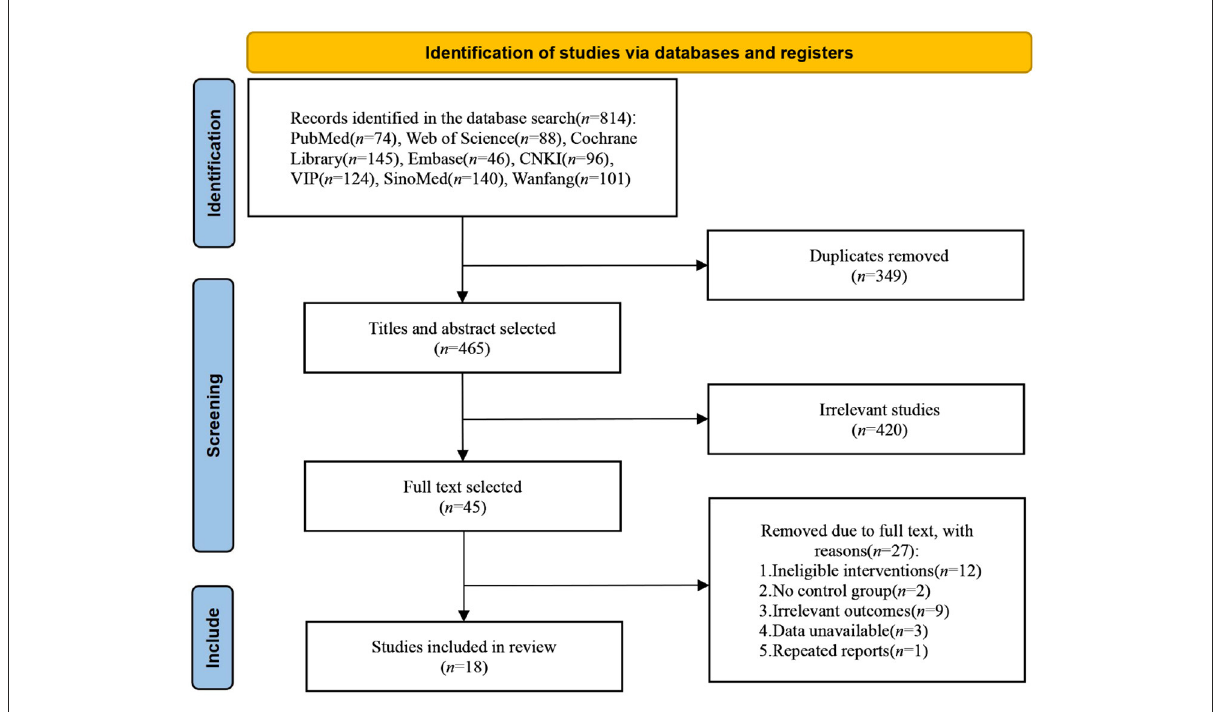
FIGURE1 Screening process of literature